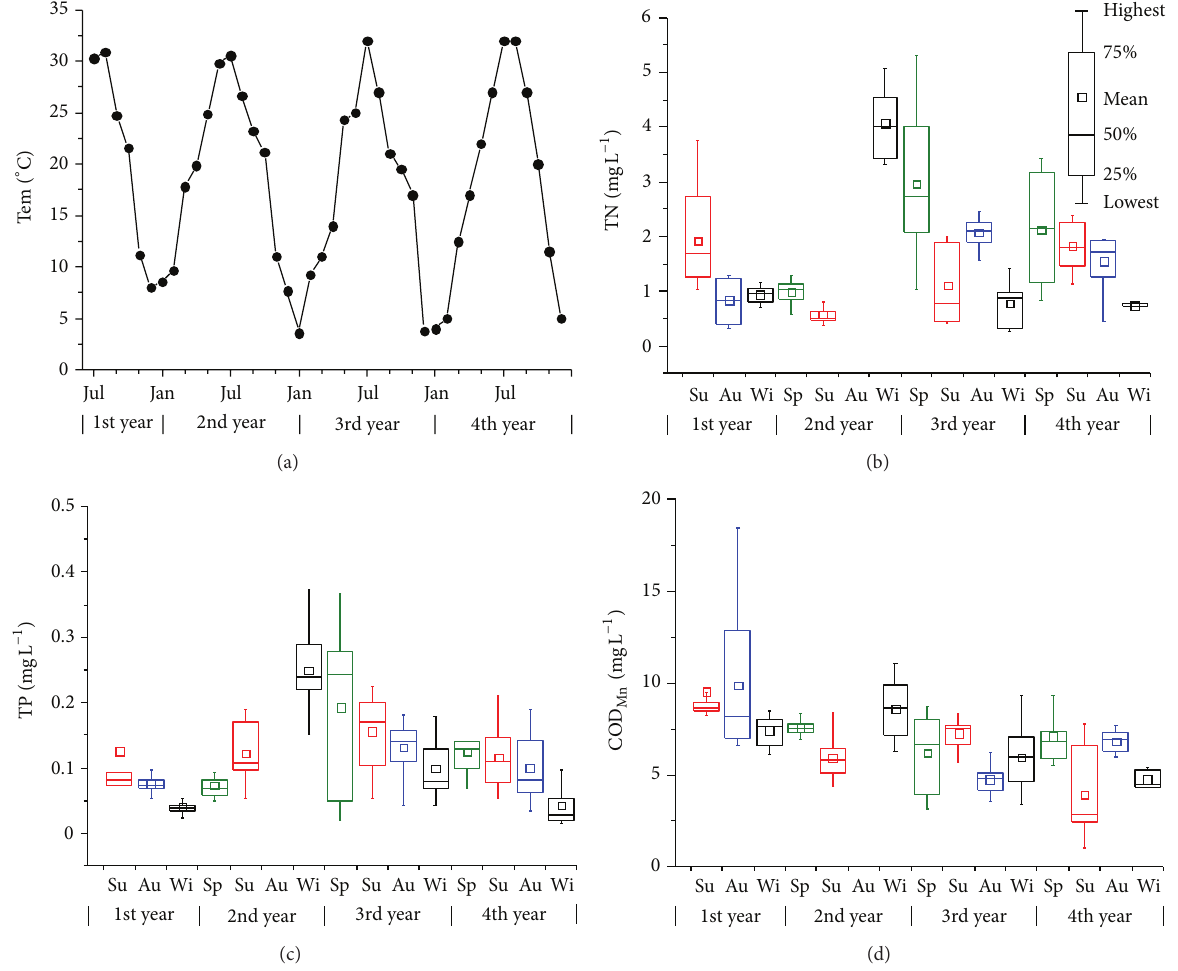
Figure 2: Seasonal dynamics of Tem, TN, TP, and COD Mn in Dadian Lake from 2006 to 2009. Outliers ( >𝑄3+1.5Δ𝑄 or <𝑄1−1.5Δ𝑄 , Δ𝑄 = 𝑄3 − 𝑄1 ) are not shown in the plots. Sp: spring (from Mar to May), Su: summer (from June to Aug), Au: autumn (from Sep to Nov), Wi: winter (from Dem to Feb). No data were recorded in the 2nd autumn except for